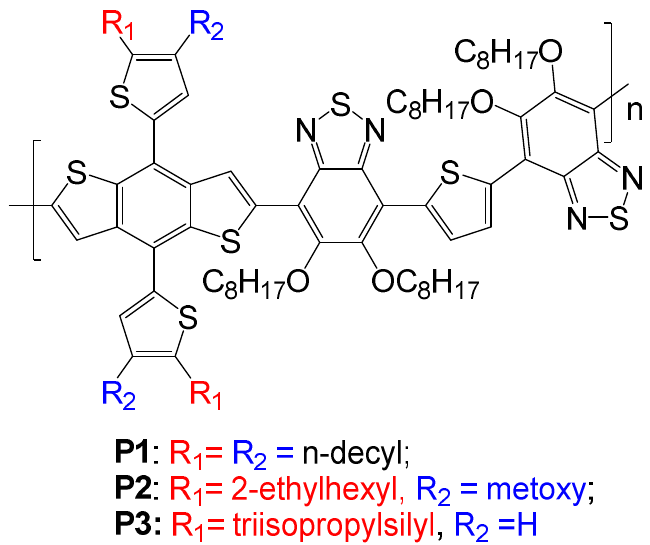
Figure 1. Conjugated polymers P1 – P3 .